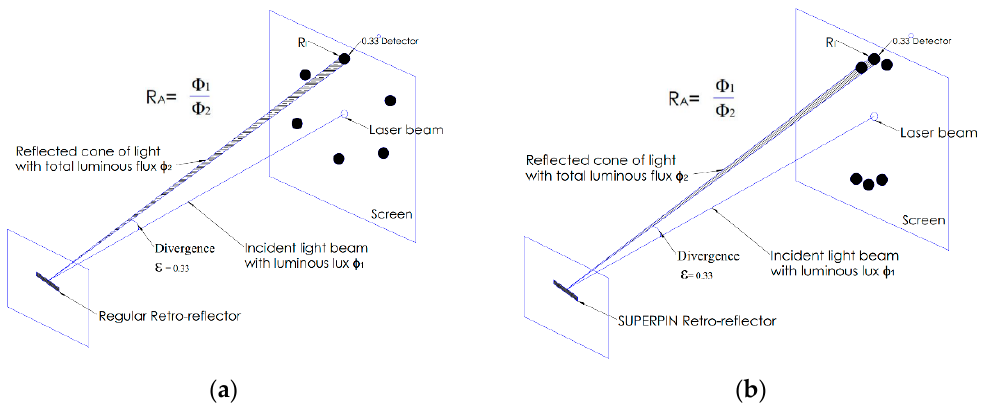
Figure 1. Retro-reflected light by ( a ) the Economic Commission for Europe (ECE) regular reflex reflector, and ( b ) the ECE SuperPin reflex reflector.